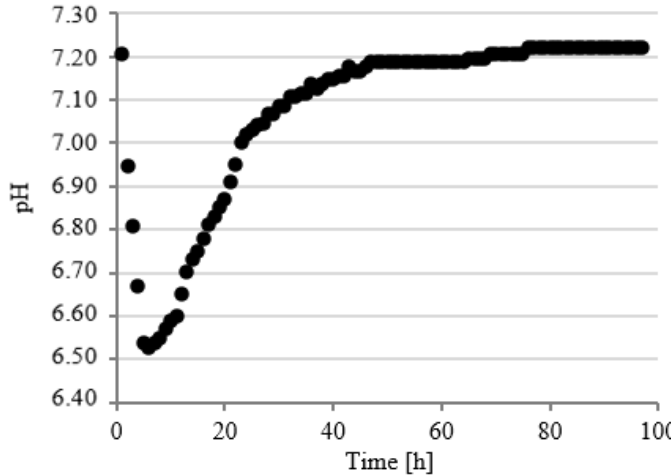
Figure 9. Course of pH changes in series 2.